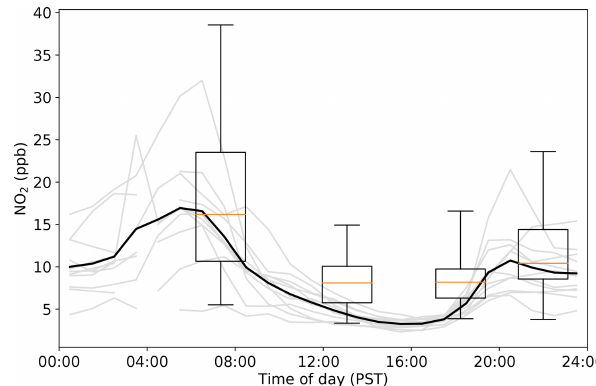
Figure 6. Box and whisker plots for flight data from RLO flights; the grey lines are data from 11 CARB surface sites (see Fig. 1). Statistics for the box and whisker plot (5th percentile, 25th per- centile, median, 75th percentile, 95th percentile): sunrise (5 . 5, 10.7, 16.2, 23.5, 38.6), afternoon (3.3, 5.7, 8.1, 10.1, 14.9), evening